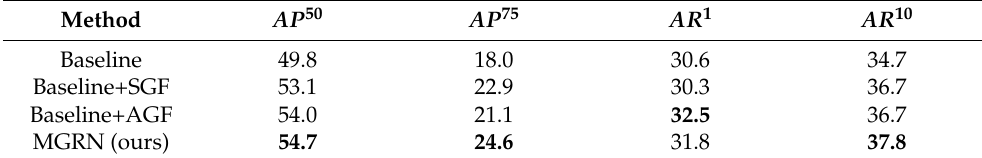
Table 3. Comparison of test results of different sub-modules. Bolded numbers indicate optimal. Method AP